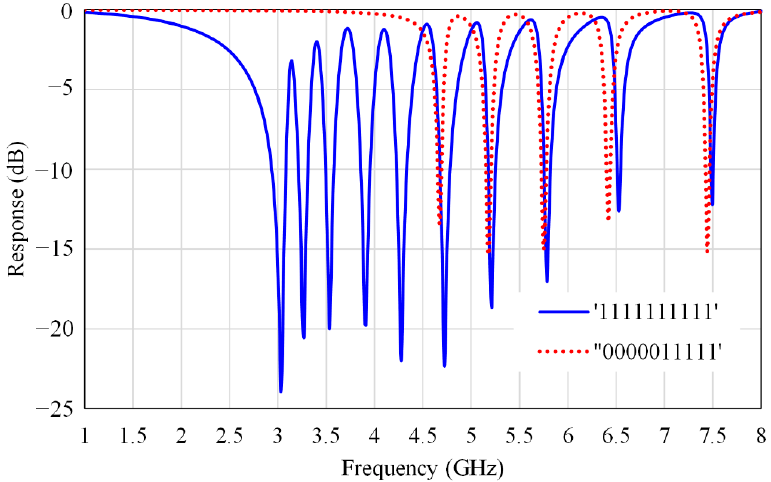
Figure 8. Simulated response of the proposed M-strips tag with two different codes: 1111111111 and 0000011111.